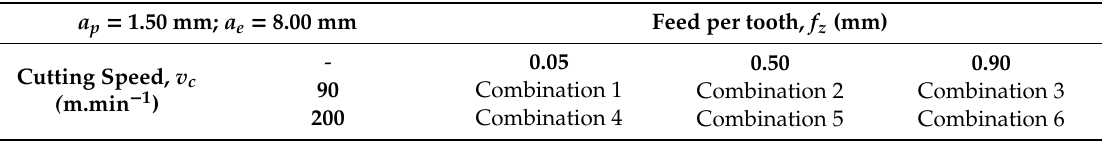
Table 5. Combinations of cutting parameters of high feed face